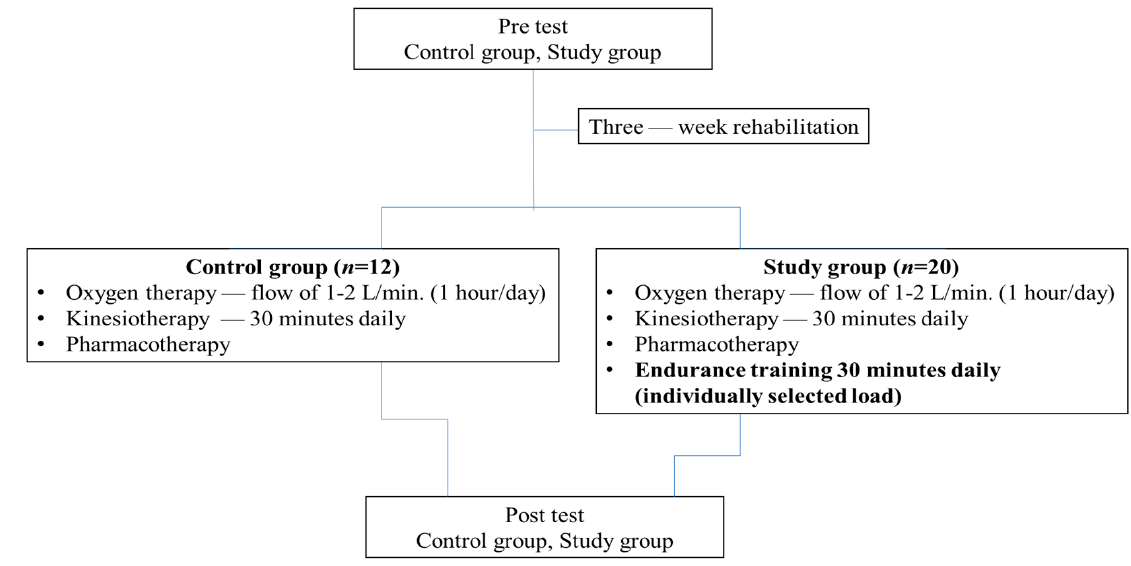
Figure 2. Research protocol.